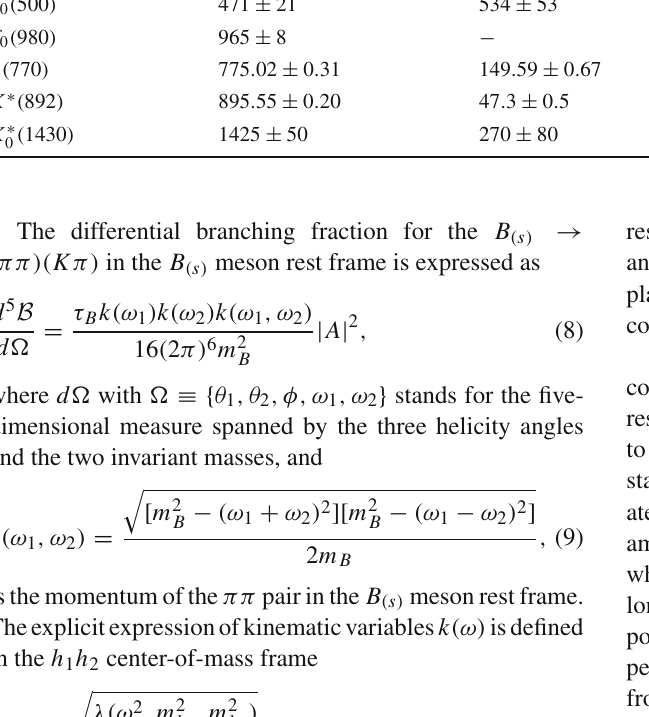
LHCb [125] Flatté BES